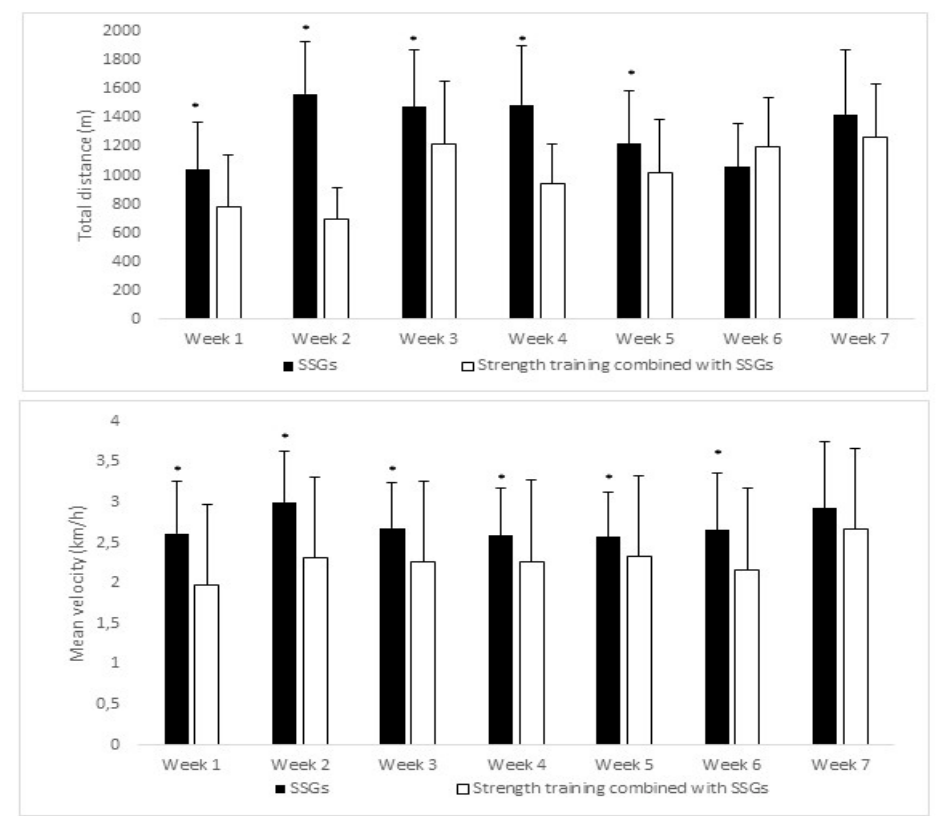
Figure 3. Total distance (m) and mean velocity (hm/k). * denotes p < 0.05